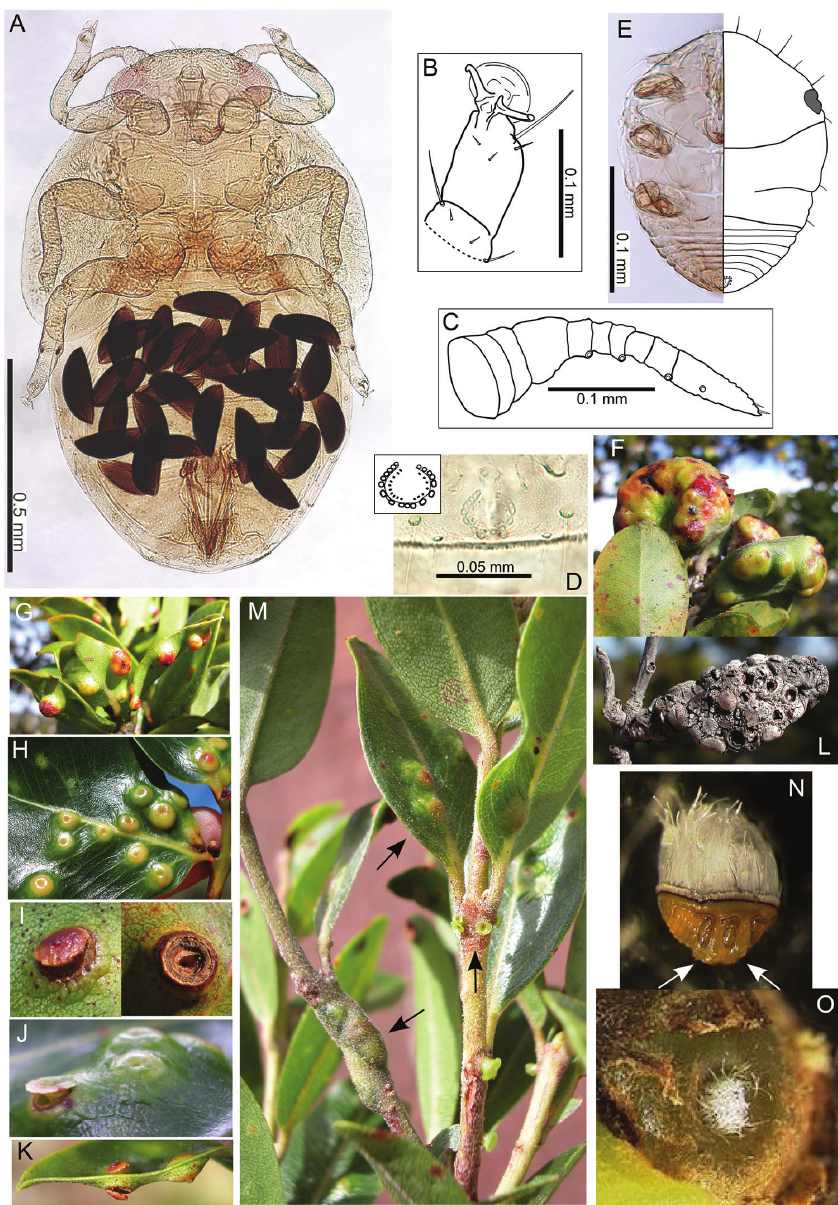
Figure 48. Pariaconus hiiaka and Pariaconus sp. immatures. A–L P. hiiaka : A 5 th instar (with eggs) B tarsi C antenna D anal ring with detail (inset) E 1 st instar F enclosed leaf galls causing leaf deformation G, H variation in shape and colouration of leaf galls I, J, K examples of gall opening by hinged circular door L severely galled leaf, necrotic and lignified in situ on stem M example of three gall types (indicated) on a single branch made by at least two Pariaconus species N–O P. sp (images by Russell Messing): N undescribed species with unusual dorsal waxy filaments and similar ventral tissue mounds (indicated) to other cup/pit gallers O thick walled cup gall of undescribed